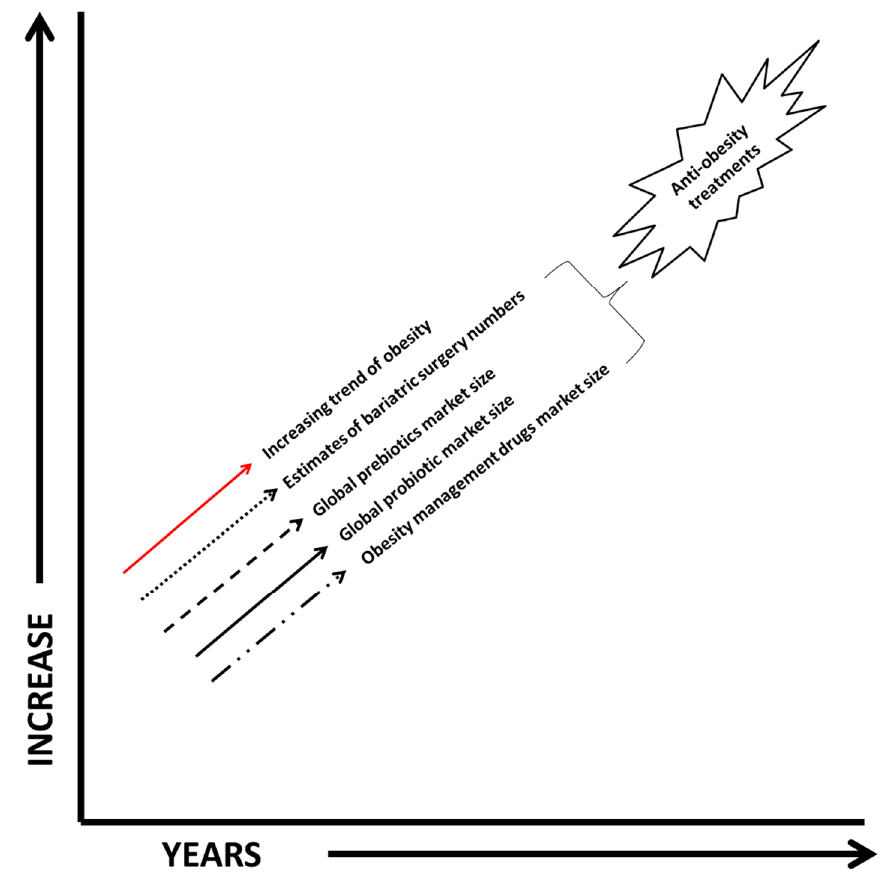
Figure 1. Ineffectiveness in obesity management despite various anti-obesity treatments [14–18].